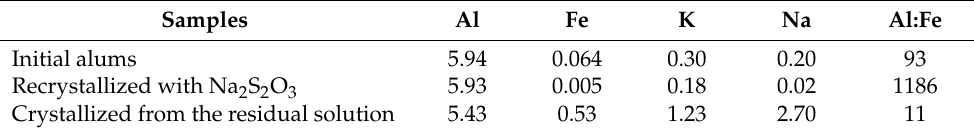
Figure 8. X-ray fluorescence spectra of various alum samples. Green line—blank (ammonium alum), blue line—initial alum; black—alum obtained by recrystallization in the presence of Na 2 S 2 O 3 . The red line is the precipitate obtained by evaporating the residual solution. (Ag anode, 50 kV/200 µ A/4 W, U 50 keV). Table 6. Composition of different solid samples (according to ICP-AES data).